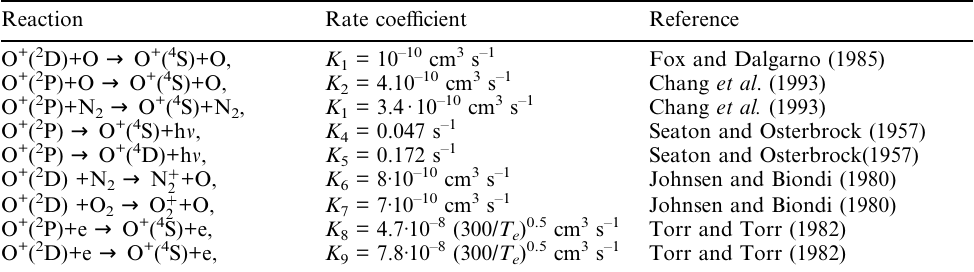
Table 2 . Chemistry of meta-